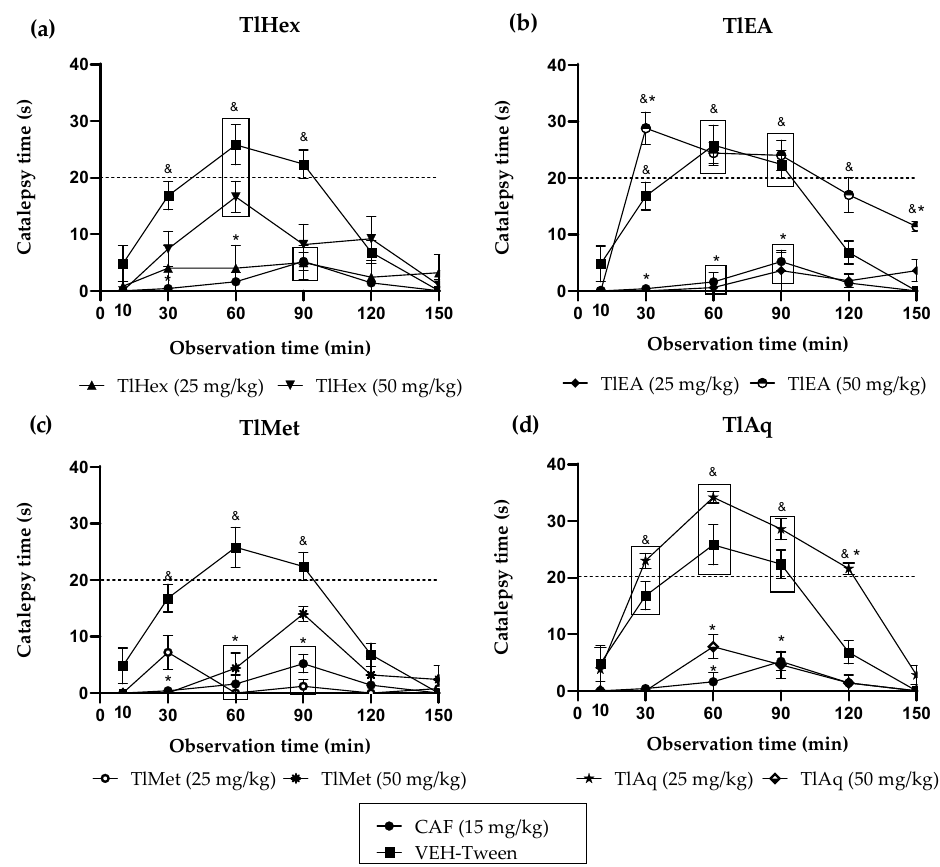
Figure 2. Effect of T. lucida extracts on cataleptic state induced with haloperidol (HAL) 0.5 mg/kg i.p., in Bar test (BT) in mice: ( a ) TlHex; ( b ) TlEA; ( c ) TlMet; ( d ) TlAq. ANOVA followed by Dunnett’s Test ( x ± S.E.M., n = 5); * p < 0.05 in comparison with the VEH-Tween group, & p < 0.05 in comparison with caffeine (CAF). 𝑥𝑥̅ HN and DF, isolated from the active extracts, presented a potentiation of cataleptic effect at doses of 1 mg/kg. The results obtained in this assay (Figure 3) indicate that the group administered with DF, at a dose of 1 mg/kg, presents a positive cataleptic state at minute 30, with a statistically significant difference in comparison with the positive con- trol group (CAF 15 mg/kg) ( & p ˂ 0.05), this positive effect increased until minute 60 until minute 90 and 120 a cataleptic potentiation is observed with a statistically significant dif- ference with respect to the animals administered only with HAL (* p ˂ 0.05). At minute 150, there is a decrease in a catalepsy of fewer than 20 s; however, there is still a statistically significant difference when compared with the positive control group and the VEH- Tween group.